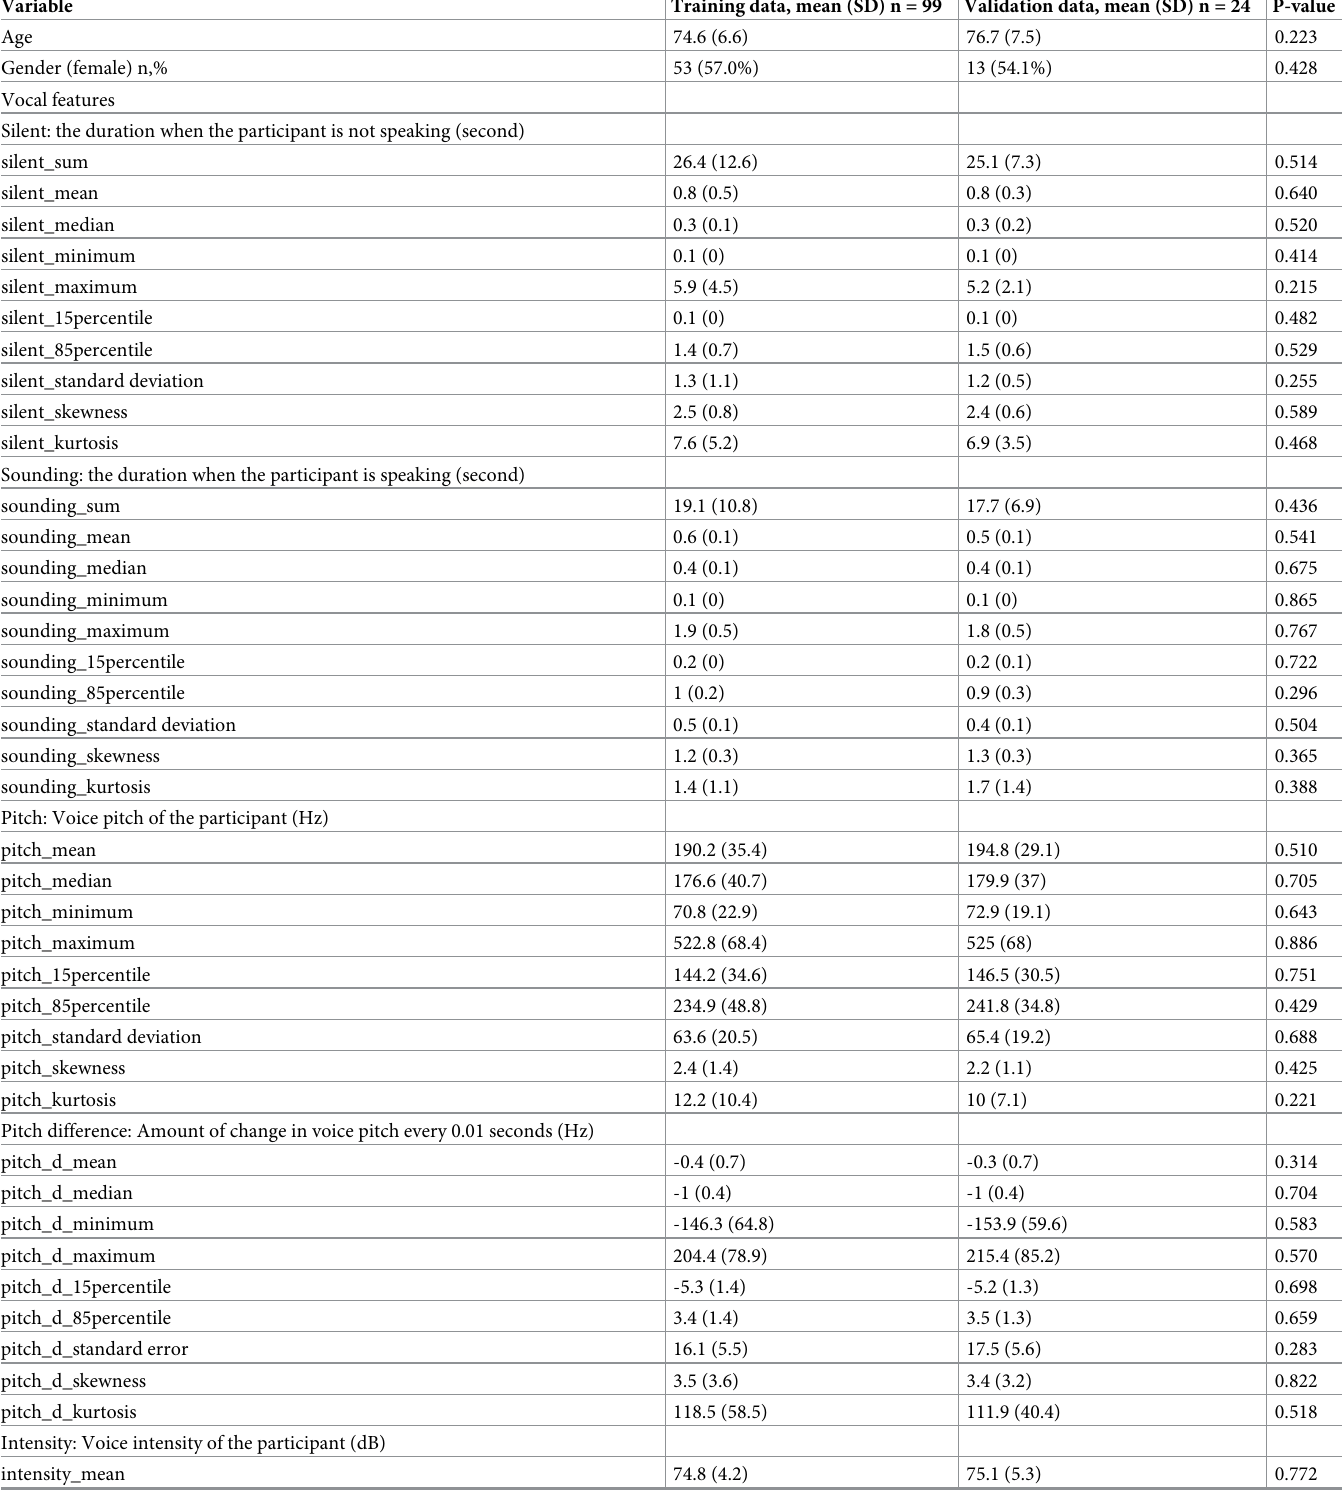
Table 2. Descriptive statistics of demographic and vocal data for participants of each group.